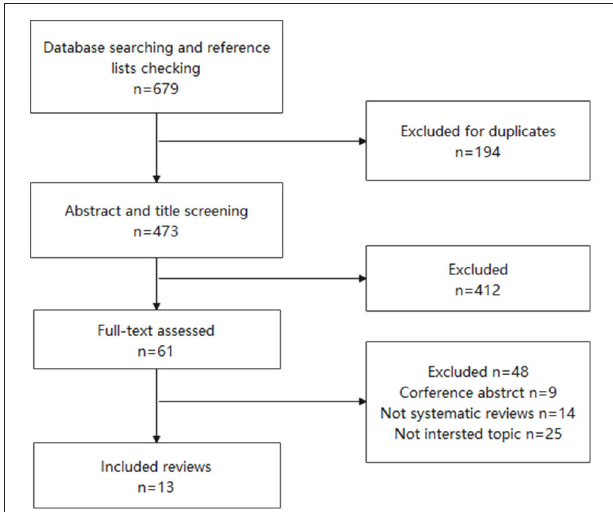
FIGURE 1 | The PRISMA flowchart of the included and excluded systematic review and